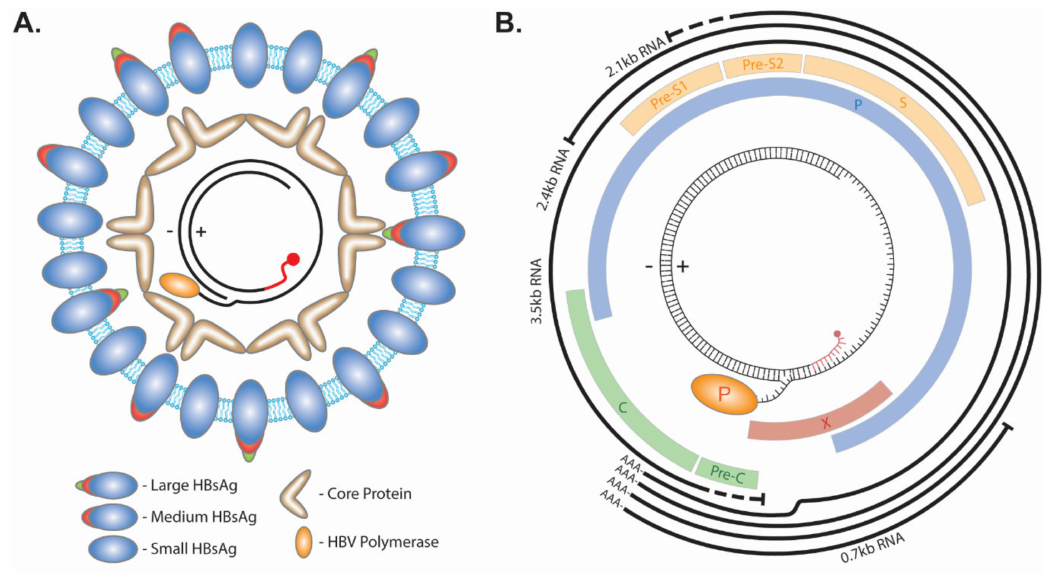
Figure 1. HBV structure and genome. ( A ) The envelope of HBV virion consists of lipids and the large, medium, and small viral surface proteins. Within the lumen of the virus, core protein forms an icosahedral capsid around the rcDNA genome which has the viral polymerase covalently attached to the 5 (cid:48) end of the ( − ) strand and a capped RNA primer (red) attached to the 5 (cid:48) end of the ( + ) strand. ( B ) The 3.2 kb HBV genome encodes four overlapping ORFs (Pre-Core / Core (Pre-C / C), Polymerase (P), Pre-S1 / Pre-S2 / S, and X) and four mRNA transcripts with an overlapping 3 (cid:48) end (3.5 kb, 2.4 kb, 2.1 kb, and 0.7